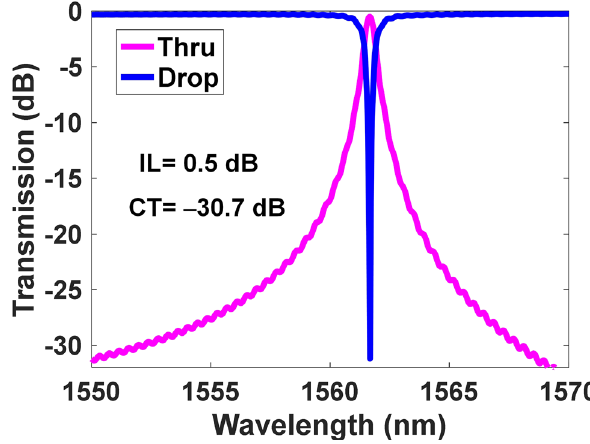
Figure 3: Simulated transmission spectra of the suspended photonic crystal nanobeam (PCN) – based Mach – Zehnder interferometer (MZI) switch.